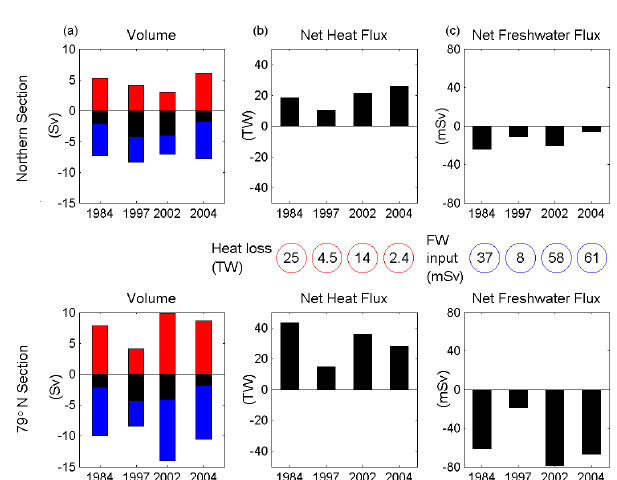
Fig. 7. Transports of (a) volume (red northward, blue southward, Fig. 7 black net) of the whole water column and (b) the net heat and (c) net freshwater fluxes relative to the mean temperature and salinity of the total transports through the two sections in each year. The heat loss and freshwater input between the sections are shown with numbers in the centre.